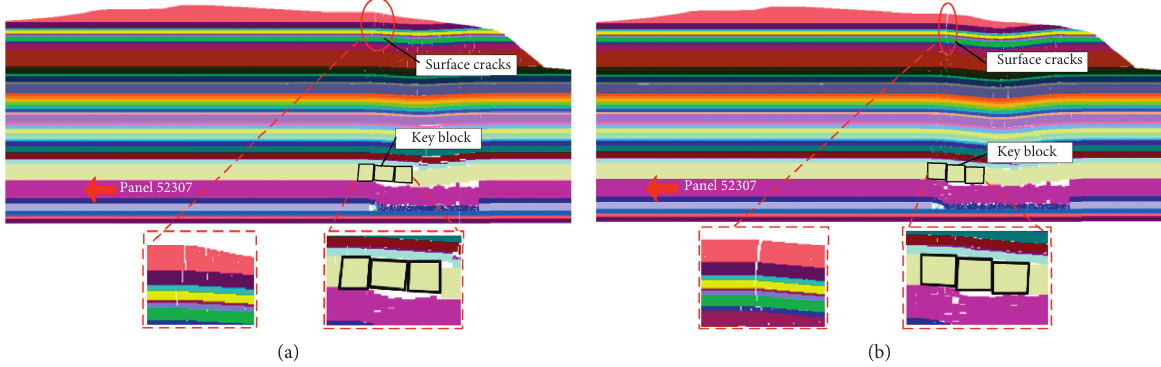
Figure 15: Periodic weighting of working face. (a) First periodic weighting. (b) Second periodic